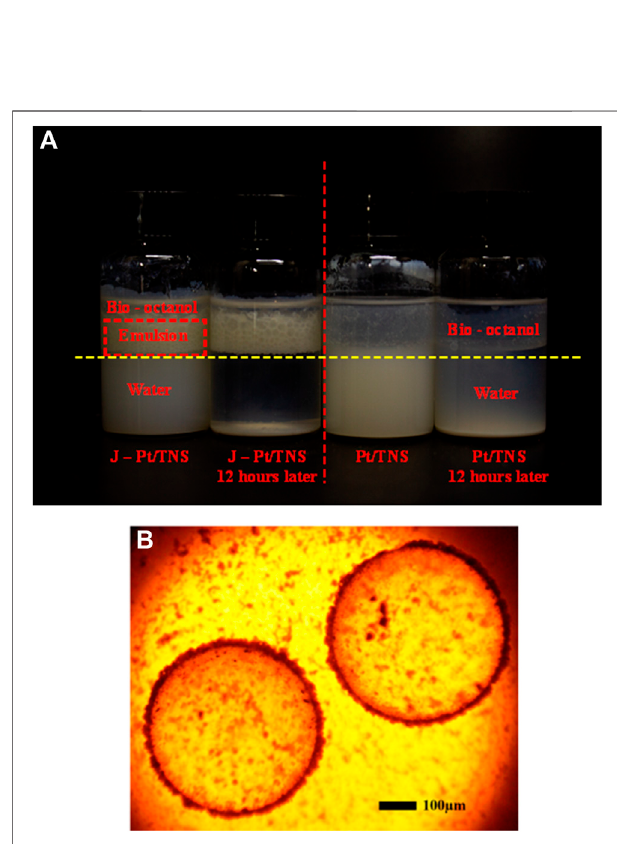
FIGURE 8 | Photographs of (A) standings of emulsi fi cation and (B) microscopic image of emulsion droplets.